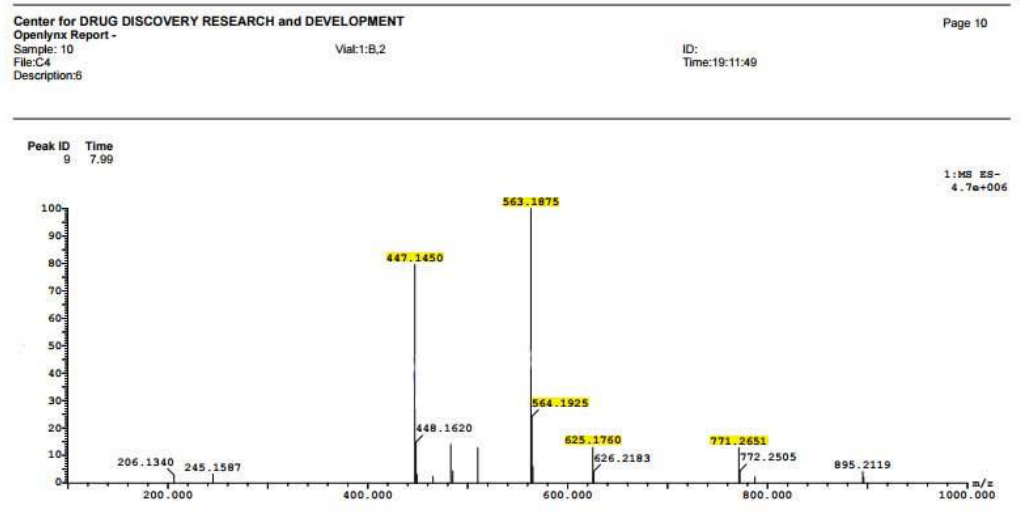
Figure 21. First mass for peak 9 at retention time 7.99 min with molecular ion [M-H] 771.2651 from n- butanol fraction. Table 7. Identified compounds by UPLC-ESI-MS/MS fragmentation of n-butanol fraction: Peak